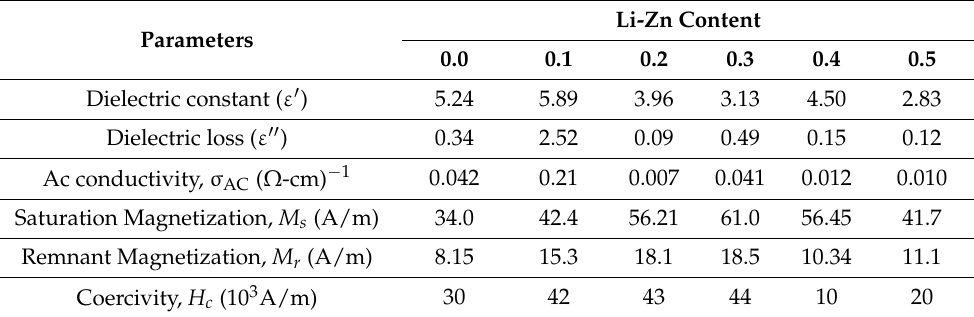
Table 2. Electrical (at frequency 1.5 GHz) and magnetic parameters of pure cobalt ferrite ( x = 0)